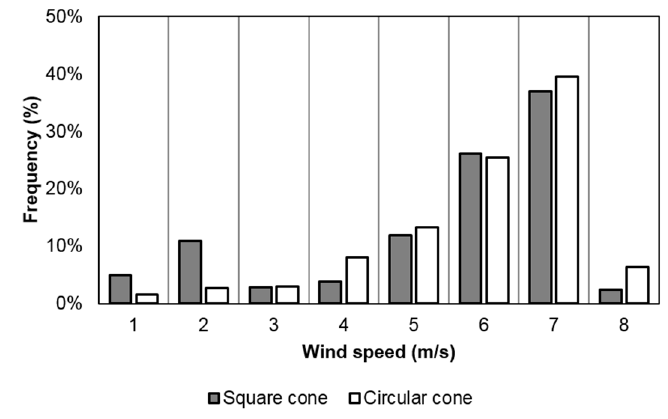
Figure 20. Probability distribution of wind speed for the square and circular cone cases.